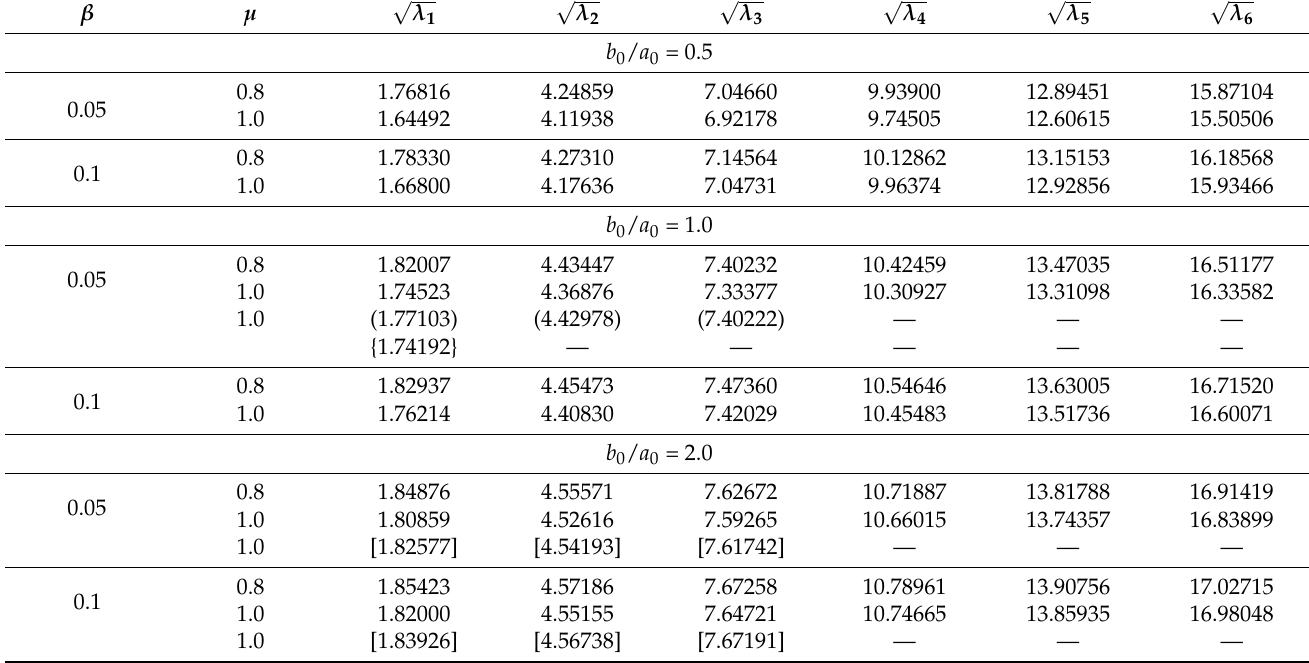
Table 2. The first six non-dimensional frequency parameters of elliptical cylinders submerged in water for different aspect ratios β of the cylinder and cylinder–water size factor µ